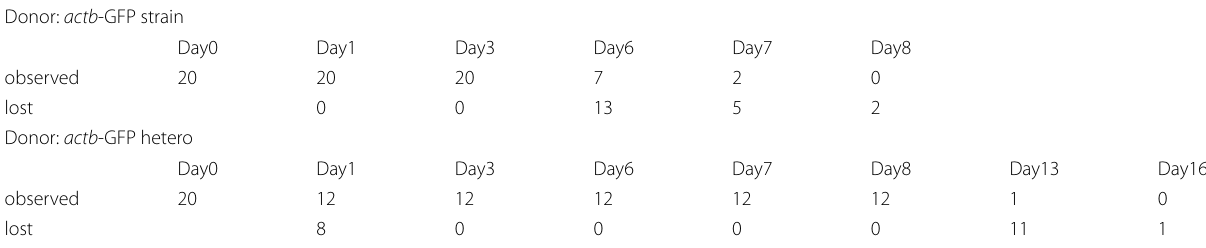
Table 5 Results of actb ‑GFP medaka and actb ‑GFP hetero scale transplantation into a d‑rR recipient Donor: actb ‑GFP